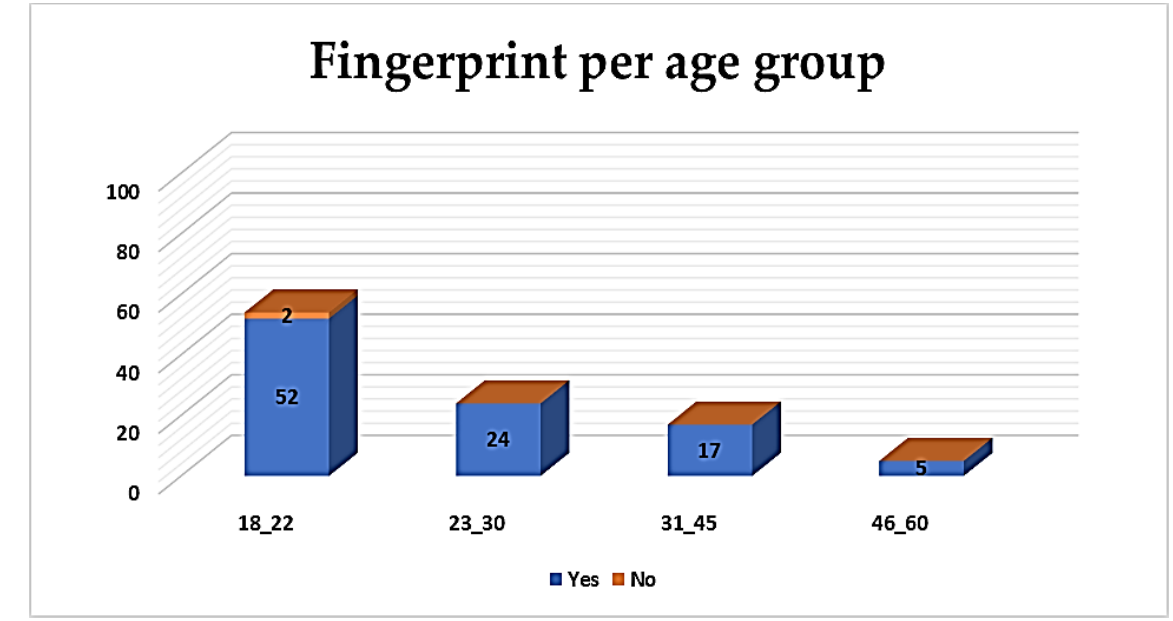
Figure 6 . Acknowledged biometric technique per age group – fingerprint . Figure 6. Acknowledged biometric technique per age group–fingerprint.